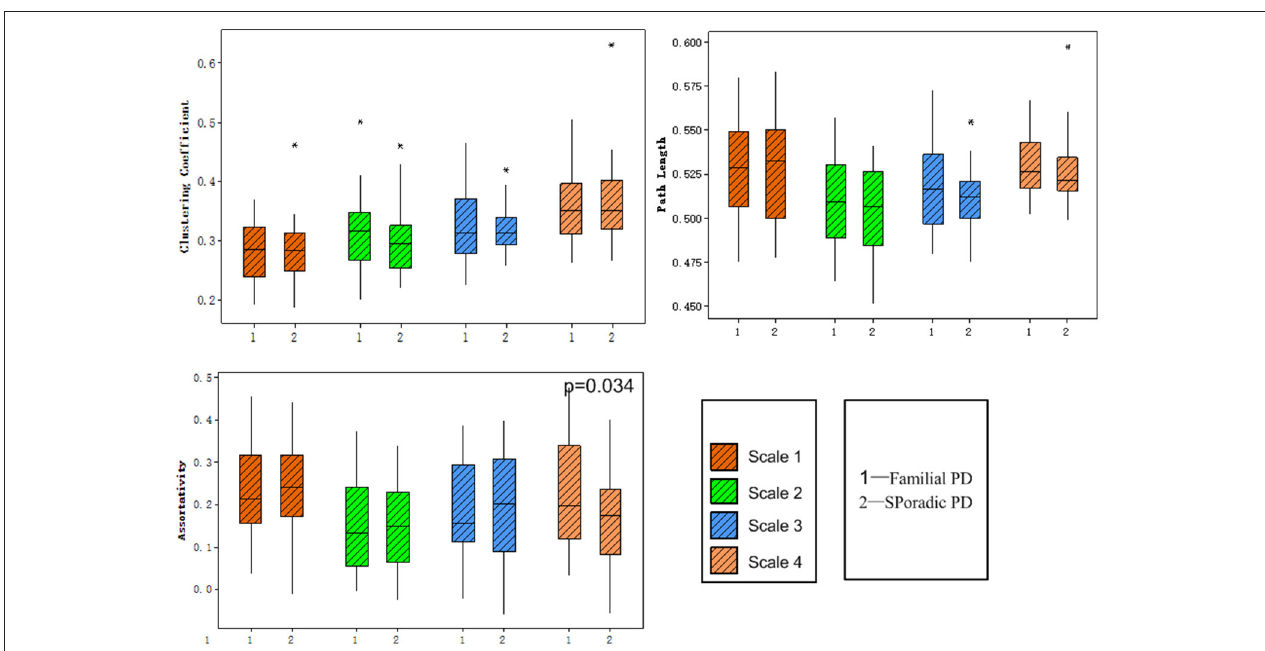
FIGURE 1 | Group comparisons of global topological metrics across four wavelet scales. These metrics include clustering coefficient (upper left) , characteristic path length (upper right) and assortativity (lower left)